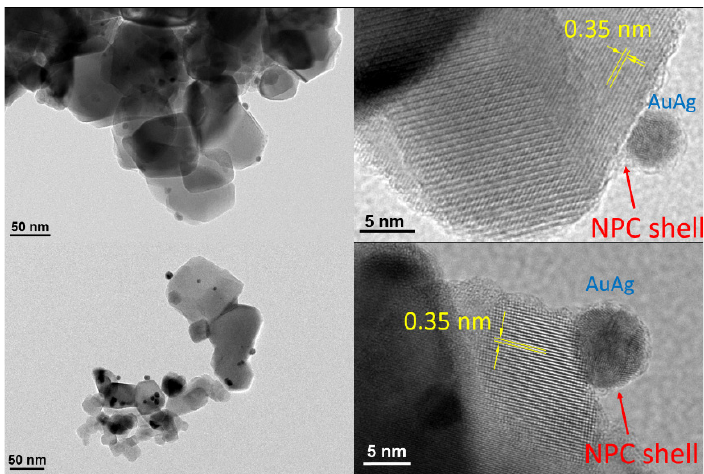
Figure 2. TEM and HRTEM images of Au-Ag-NCS-TiO 2 nanohybrids 2 ( up ) and 3 ( bottom ). The HAADF-STEM-EDS study of Au-Ag-NPC-TiO 2 nanohybrid 2 was performed